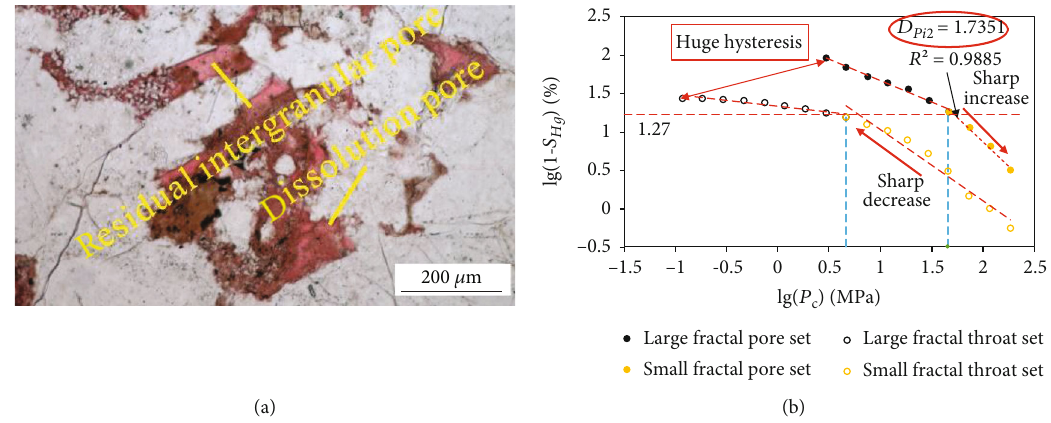
Figure 9: (a) Optical observation and (b) double logarithmic plots of wetting phase saturation versus capillary pressure from PCMI experiments for the type P3 sample from